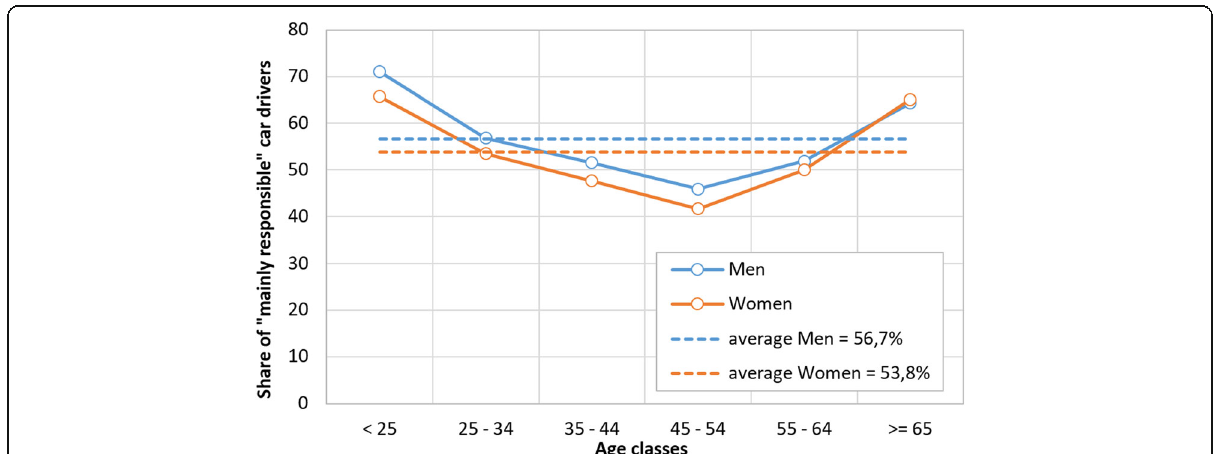
Fig. 1 Share of mainly responsible car drivers in the group of all car drivers with specified responsibility involved in motorway accidents with respect to age and gender of the